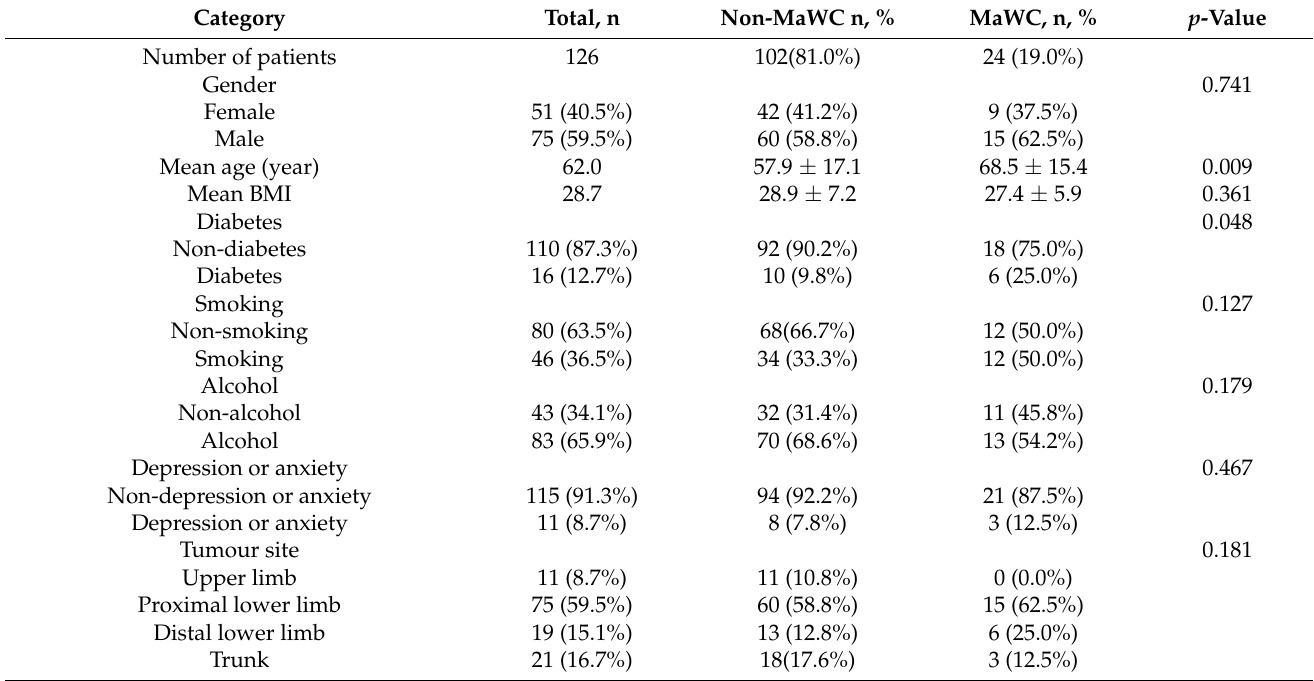
Table 1. Baseline characteristic of